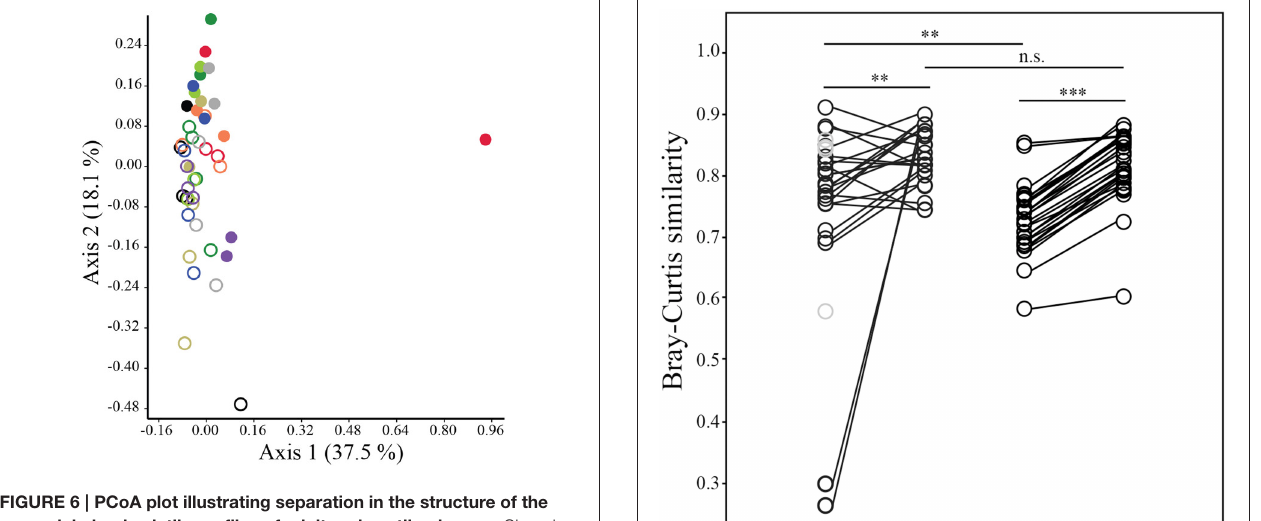
FIGURE 6 | PCoA plot illustrating separation in the structure of the uropygial gland volatile profiles of adult and nestling juncos. Closed circles denote adults, while open circles denote nestlings. Color-coding reflects nest identity.